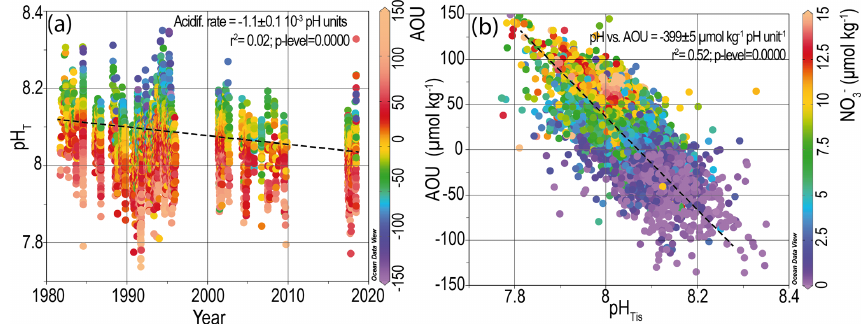
Figure 5. Time series of pH ARIOS data. The black line depicts the long-term trend. Scatter diagram of AOU vs. pH T including the nitrate concentration shown as the colour of every dot. Table 2. Seasonal amplitude of monthly pH means (SSrange) and long-term trends ( t interannual ) of pH in five regions, and significant regression coefficients between the in situ pH measurements and the monthly mean pH values ( r 2 ss) and the regression coefficient of the temporal variability of the deseasonalized pH measurements ( r 2 ). SSrange r 2 ss t interannual r 2 p value OCEAN 0.050 0.17 − 0 . 0012 ± 0 . 0002 0.21 0.0000 SHELF 0.050 0.06 − 0 . 0017 ± 0 . 0003 0.15 0.0009 OUTER 0.120 0.24 − 0 . 0027 ± 0 . 0003 0.21 0.0000 MIDDLE 0.130 0.28 − 0 . 0022 ± 0 . 0005 0.03 0.0000 INNER 0.260 0.47 − 0 . 0039 ± 0 . 0005 0.34